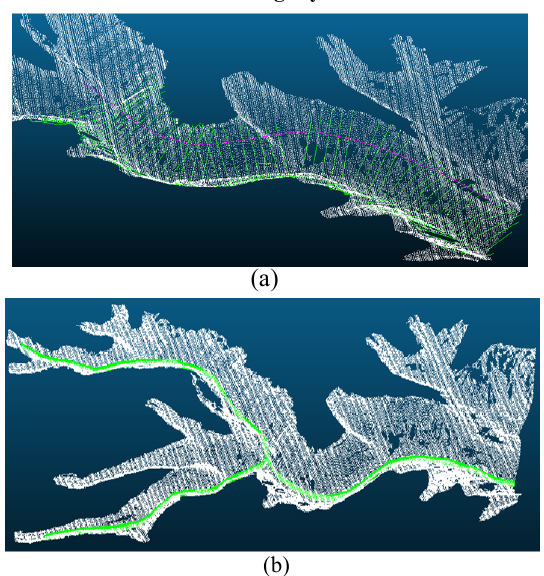
Figure 7. Extraction of gully parameters. (a)the cross-section profile of gully; (b) the bottom line of gully